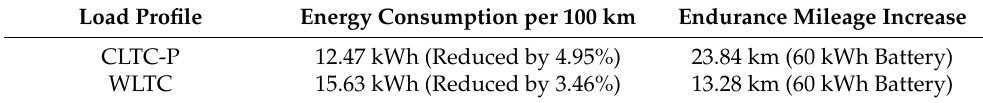
Table 5. Endurance Mileage Increase using SiC Inverters under Different Load